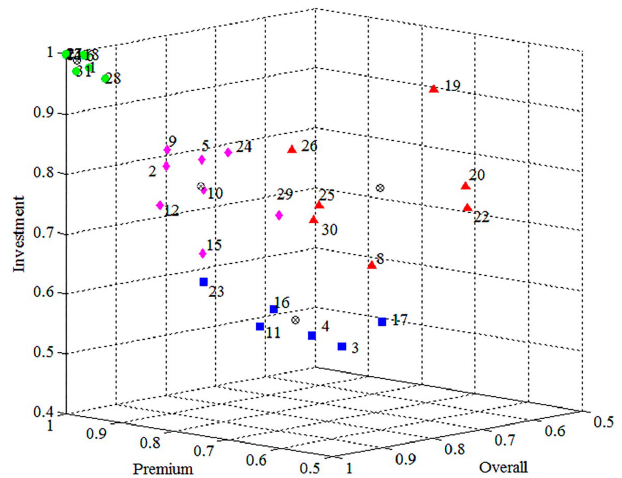
3. 3D plot for K-Means cluster analysis Note: Four clusters are shown with circle (top), diamond (middle high), triangle (middle low), and square (bottom) colours. See Appendix Table A2, for insurers’